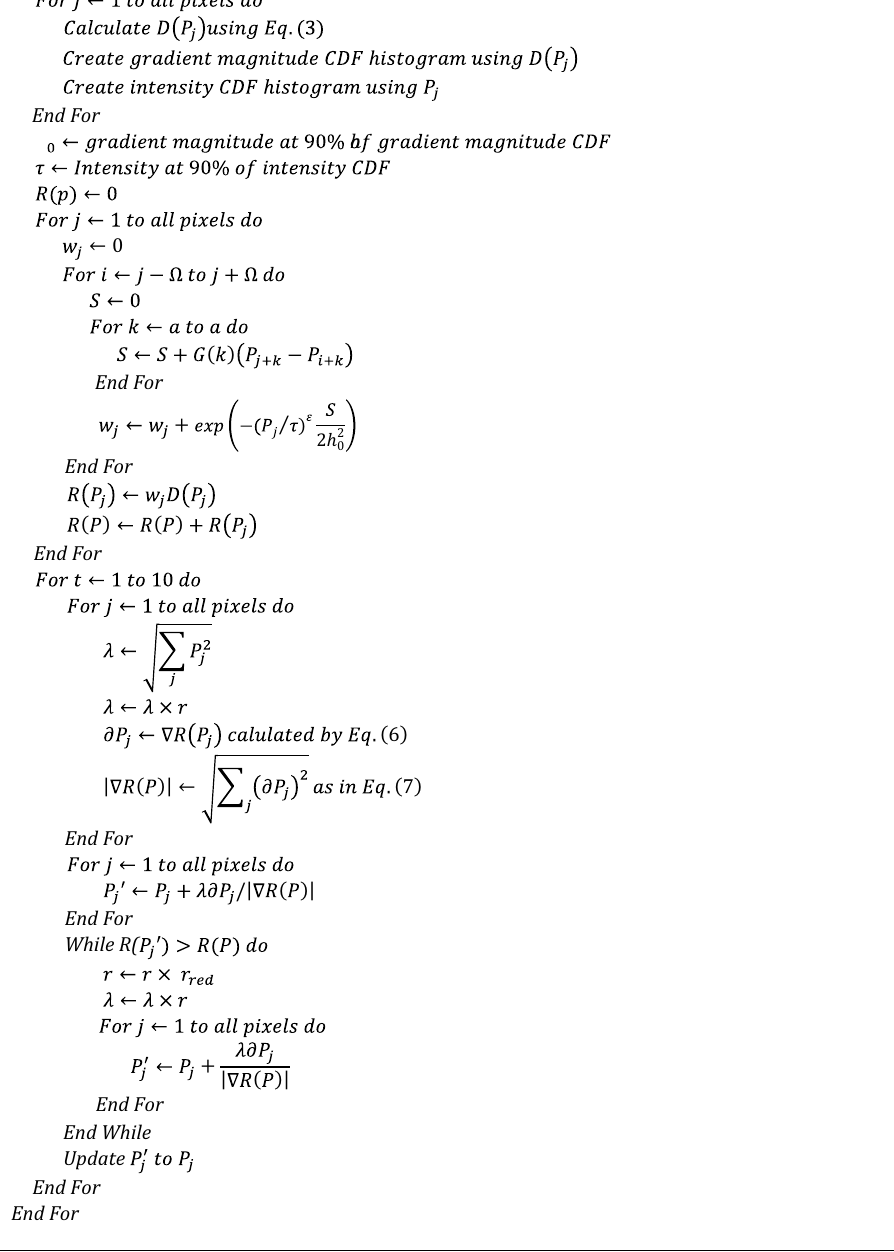
Calculate Gaussian kernel with a